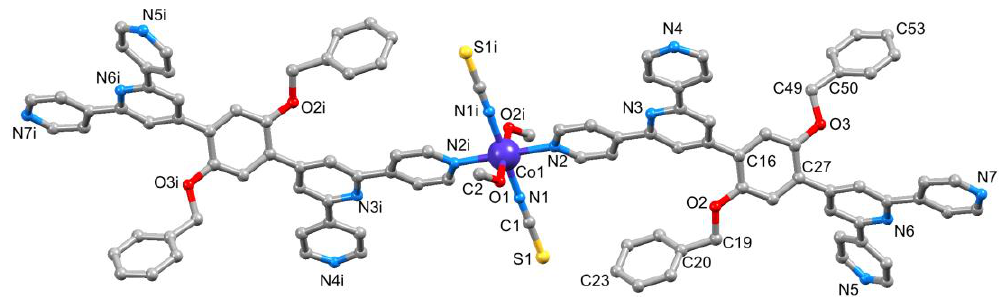
Figure 6. Molecular structure of [Co(NCS) 2 (MeOH) 2 ( 5 ) 2 ]·2CHCl 3 ·2MeOH with solvent molecules and H atoms omitted. Selected bond distances and angles: Co1–O1 = 2.138(3), Co1–N1 = 2.090(4), Co1–N2 = 2.167(3) Å , O1–Co1–N2 = 86.80(12), O1–Co1–N1 = 88.39(15), N2–Co1–N1 = 88.06(13), N1–Co1–N2 i = 91.94(13), N1–Co1–O1 i = 91.61(15), O1–Co1–N2 i = 93.20(12)°. Symmetry code i = 1 − x , 3 − y , − z .